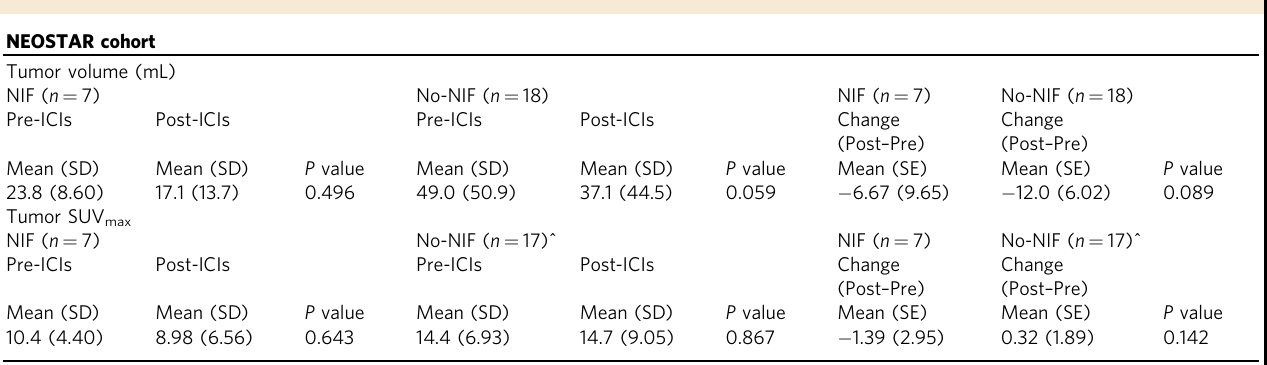
Table 3 Changes in tumor volume and SUV max in NEOSTAR patients with abnormal nodes post-therapy. NEOSTAR